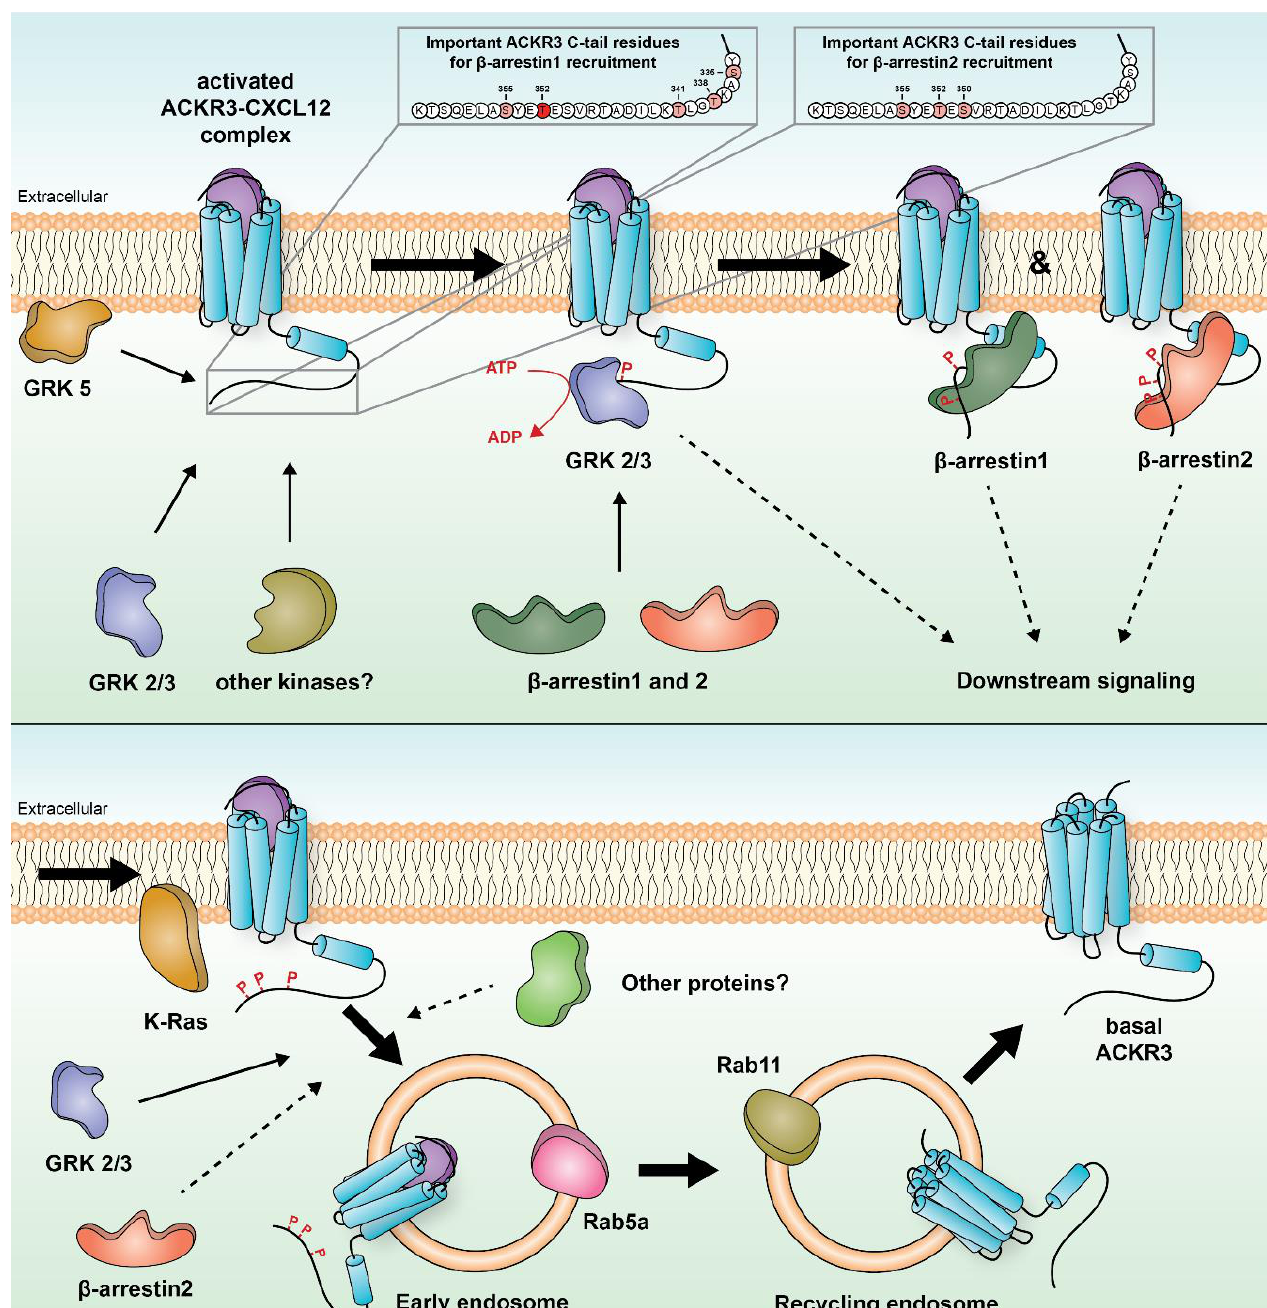
Scheme 2. Proposed model for CXCL12-induced ACKR3 protein recruitment, trafficking and internalization. Upper panel: Upon stimulation via CXCL12, GRK2/3/5, along with potential other kinases, are recruited and phosphorylate the C-tail of the receptor. The phosphorylation of specific residues of the receptor’s C-tail is then recognized by β-arrestin1 and β-arrestin2, and/or other proteins to trigger downstream signaling. Lower panel: Activation of ACKR3 triggers internalization to the early endosome (Rab5a), via GRK2/3 and β-arrestin2, and other proteins independently from the canonical β-arrestins. It is then followed by recycling (Rab11) of the receptor to the cell surface.